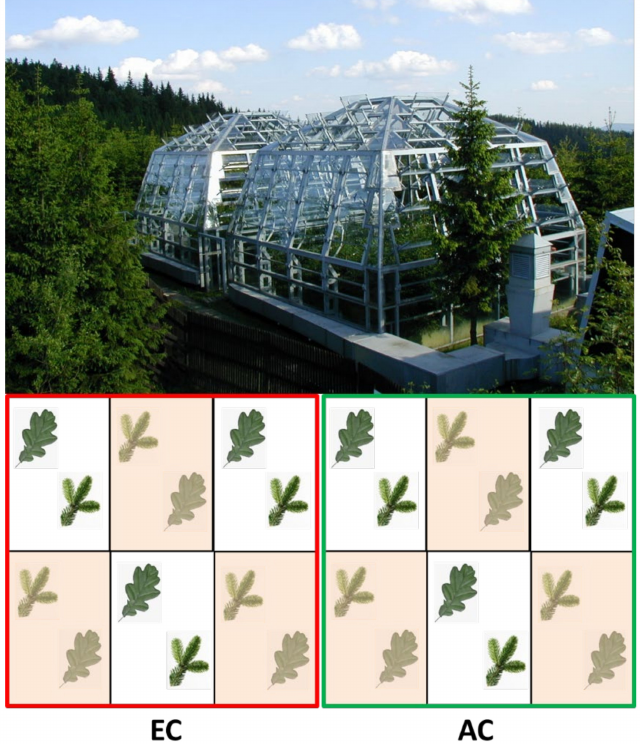
Figure 1. Photograph of cultivation domes with adjustable lamellar windows (top panel) and schematic drawing of the experiment layout (bottom panel). Each dome was divided into six blocks. Individual blocks (repetition; n = 3) are bounded by a thin black line. Open blocks = well-watered treatment (gular watering of 20 mm per week during vegetation period); colored blocks = water- limited treatment (no irrigation for 5 weeks before the measurements); AC = ambient CO 2 concentra- tion (~400 µ mol CO 2 mol –1 ); EC = elevated CO 2 concentration (~700 µ mol CO 2 mol –1 ). Each dome (10 × 10 m in size) was split into six blocks (Figure 1). Each